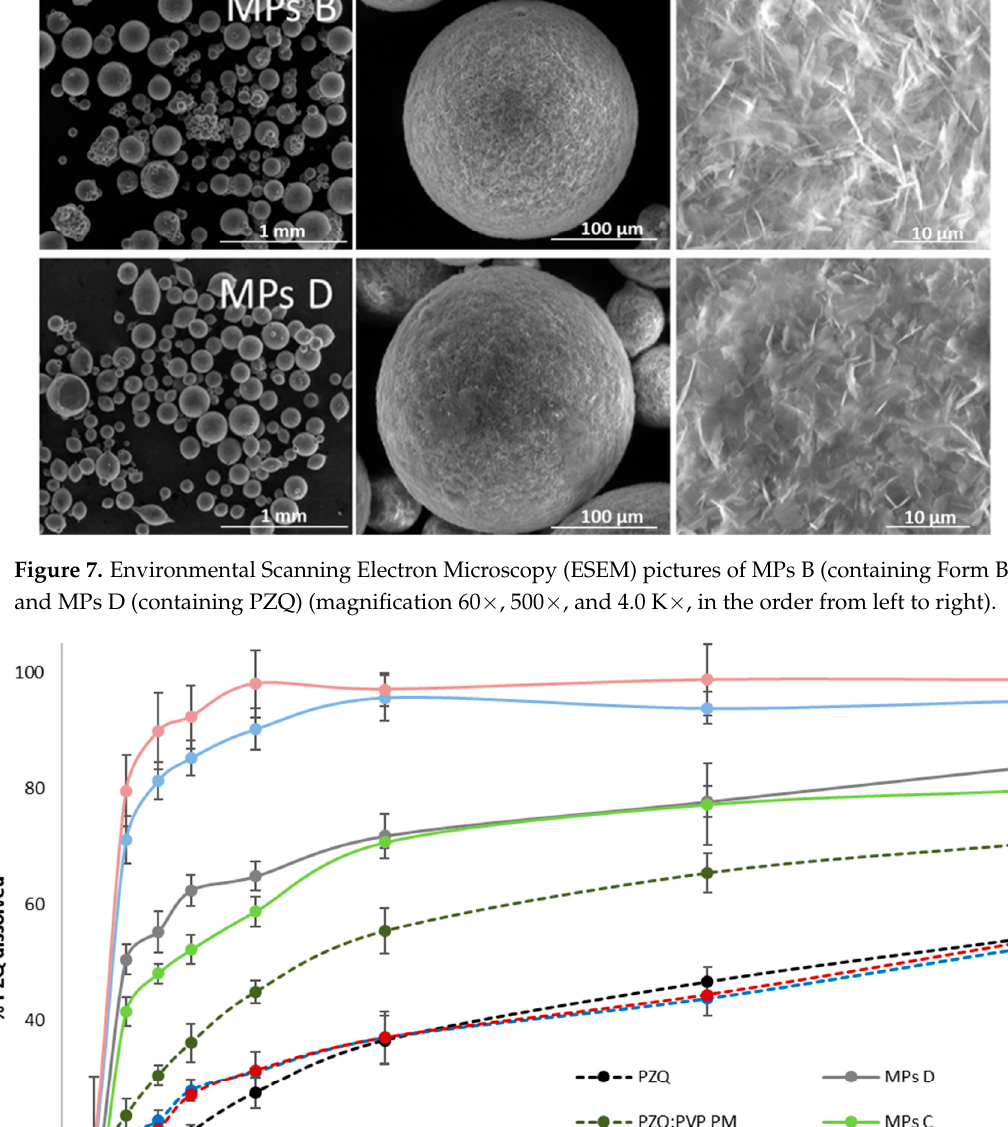
8 of 19 Figure 6. Comparison of the solubility data of the analyzed samples (**indicates significant difference). In agreement with previous findings [15], the surface of both MPs B and D appeared to be quite rough (Figure 7), which is a typical feature of Gelucire ® 50/13-based microparticles obtained by the spray congealing technique. The morphological analysis also revealed that the MPs D sample mainly consists of spherical non-aggregated microparticles, and only a few elongated particles could be